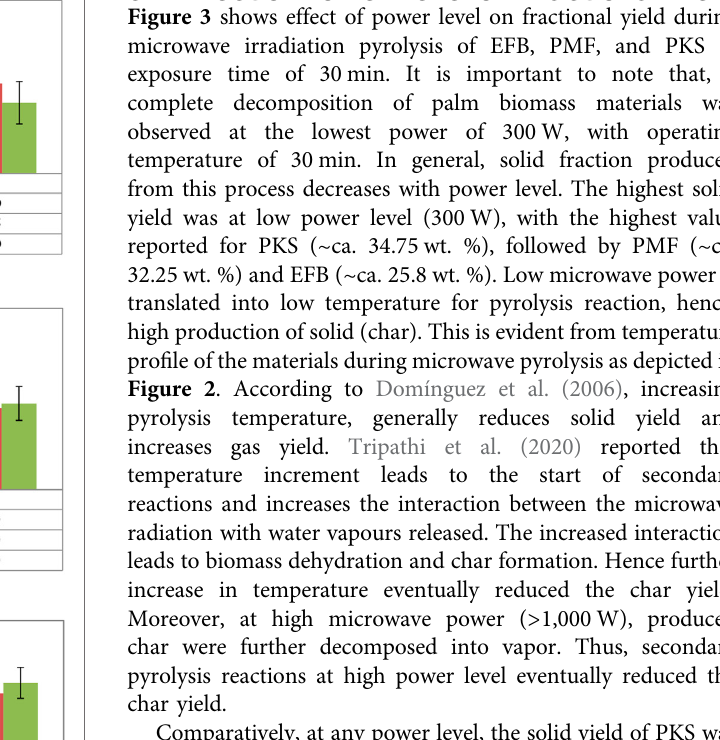
Frontiers in Chemical Engineering |